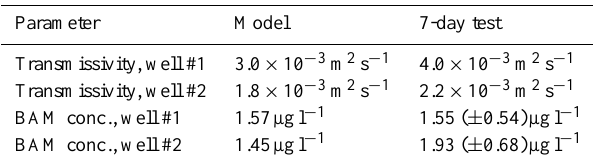
Table 5. Results of model validation. The locations of the reme- diation wells are shown in Fig. 2. The analysis error for the BAM concentrations was ±